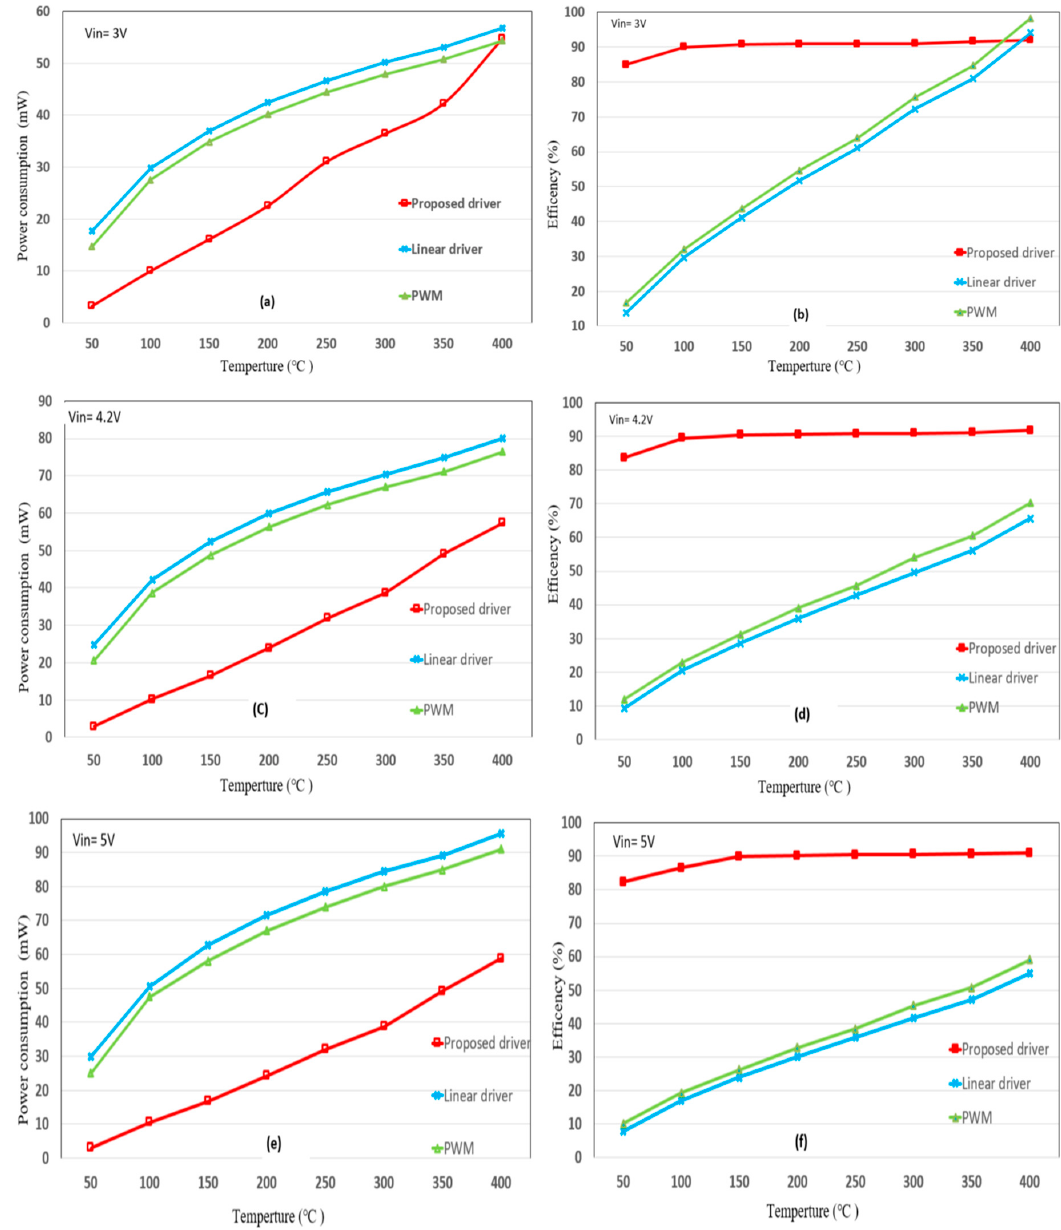
Figure 9. Comparison of power consumption and energy-conversion e ffi ciency between the proposed method and the traditional method: ( a , b ) V in = 3 V, ( c , d ) V in = 4.2 V, ( e , f ) V in = 5